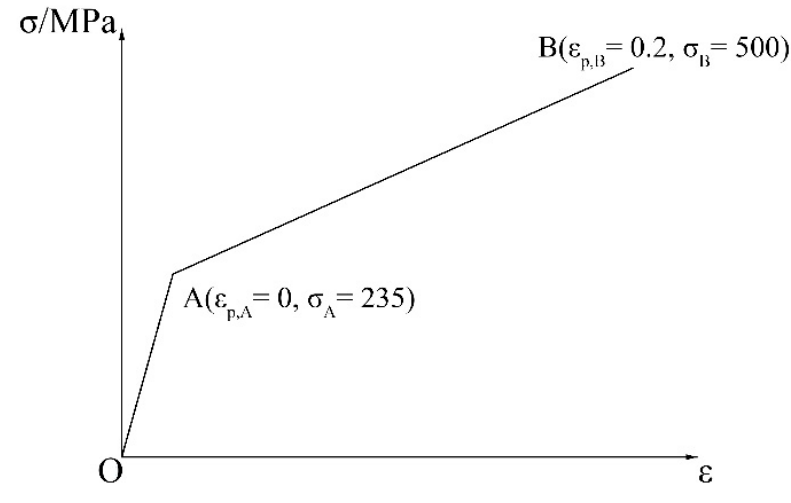
Figure 4. Stress–strain curve of the material. OA and AB represent the elastic and plastic stages, respectively, σ A and σ B represent the stress at points A and B, respectively, σ A is the yield stress, and ε p,A and ε p,B represent the plastic strain at the two points.